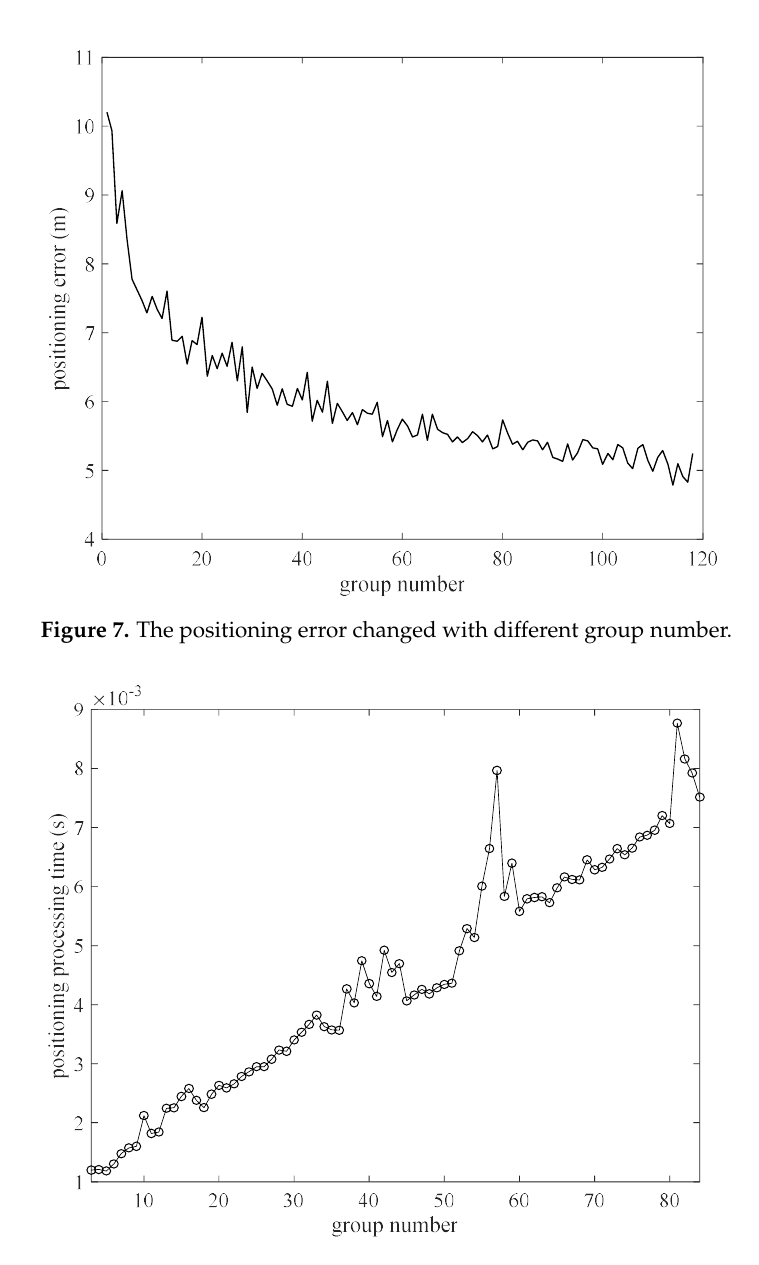
Figure 8. The positioning time changes with different group number.